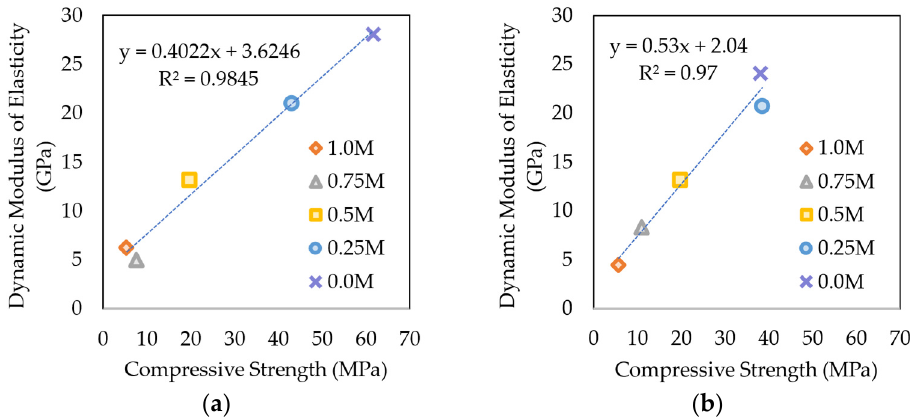
Figure 13. Correlation between the dynamic modulus of elasticity and compressive strength for: ( a ) OAA mortars and ( b ) CAA mortars. ( a ) OAA mortars and ( b ) CAA